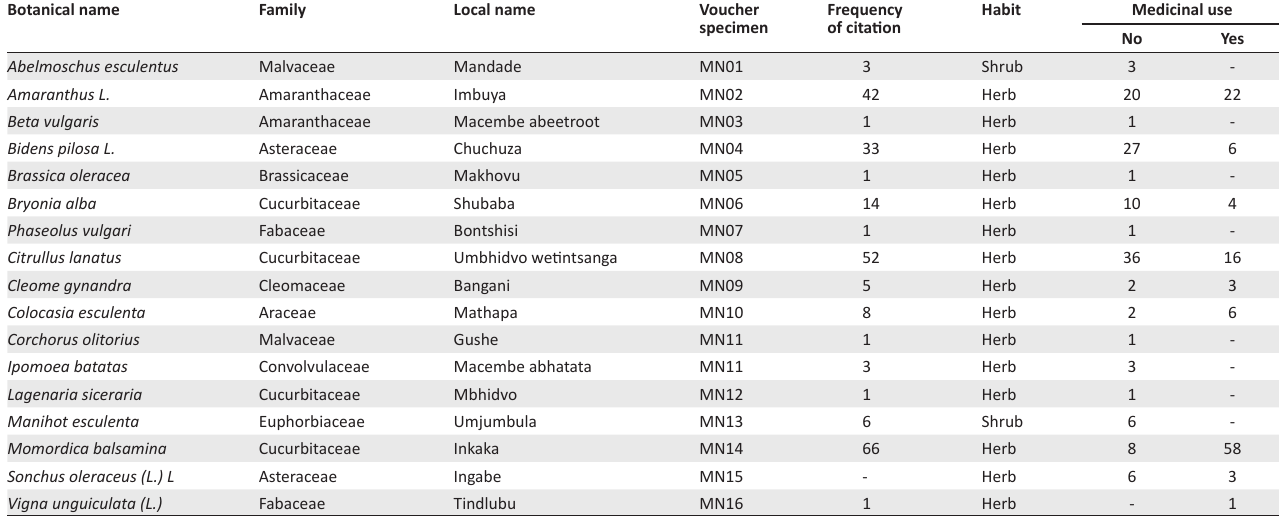
TABLE 2: Indigenous leafy vegetables for medicinal use in four villages of Mpumalanga